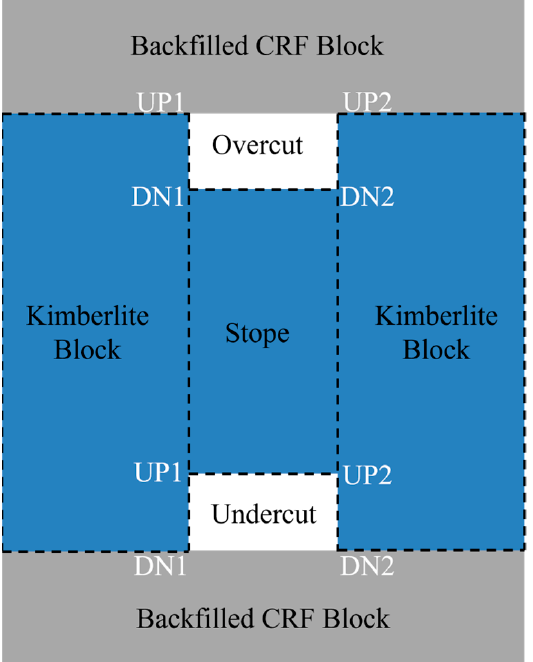
Figure 13. A profile of the chosen corners in the overcut and undercut accesses.